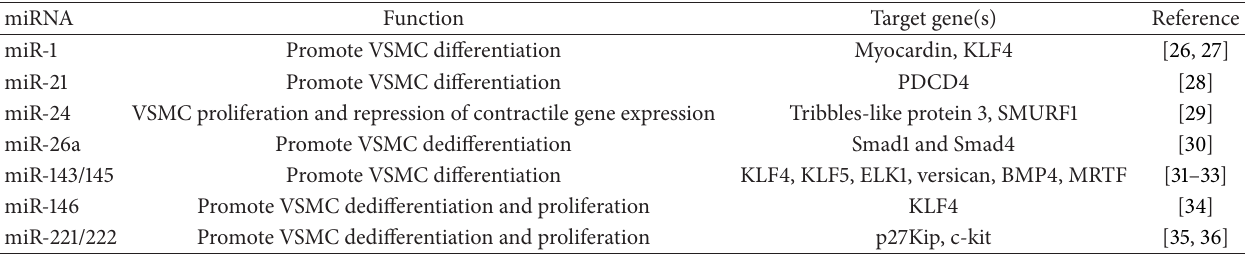
Table 1: Vascular smooth muscle cells and miRNA